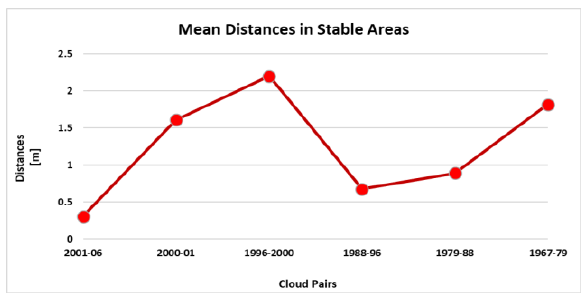
Figure 4. The mean distances in stable parts of the area evaluated in all cloud pairs.